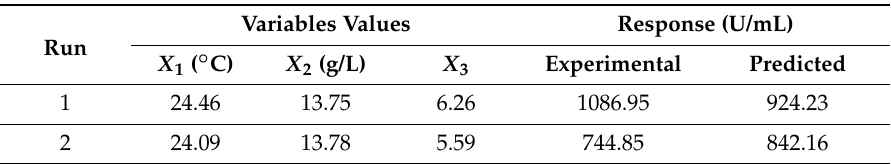
Table 6. Experimental condition of the